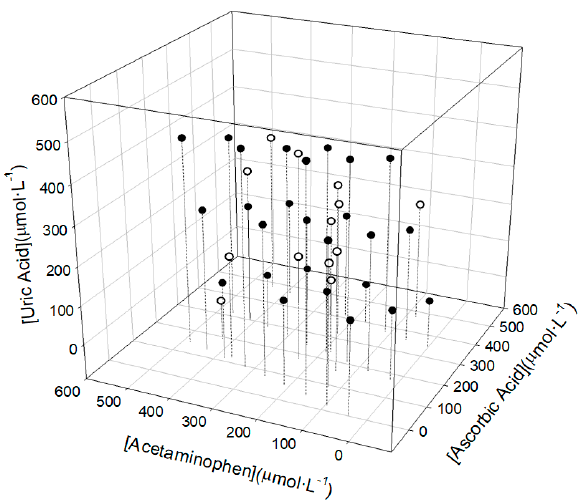
Figure 4. Representation of the tilted factorial experimental design employed (3 3 ) where it can be observed how the test samples (in white) are distributed covering all the space of the training samples (in black).